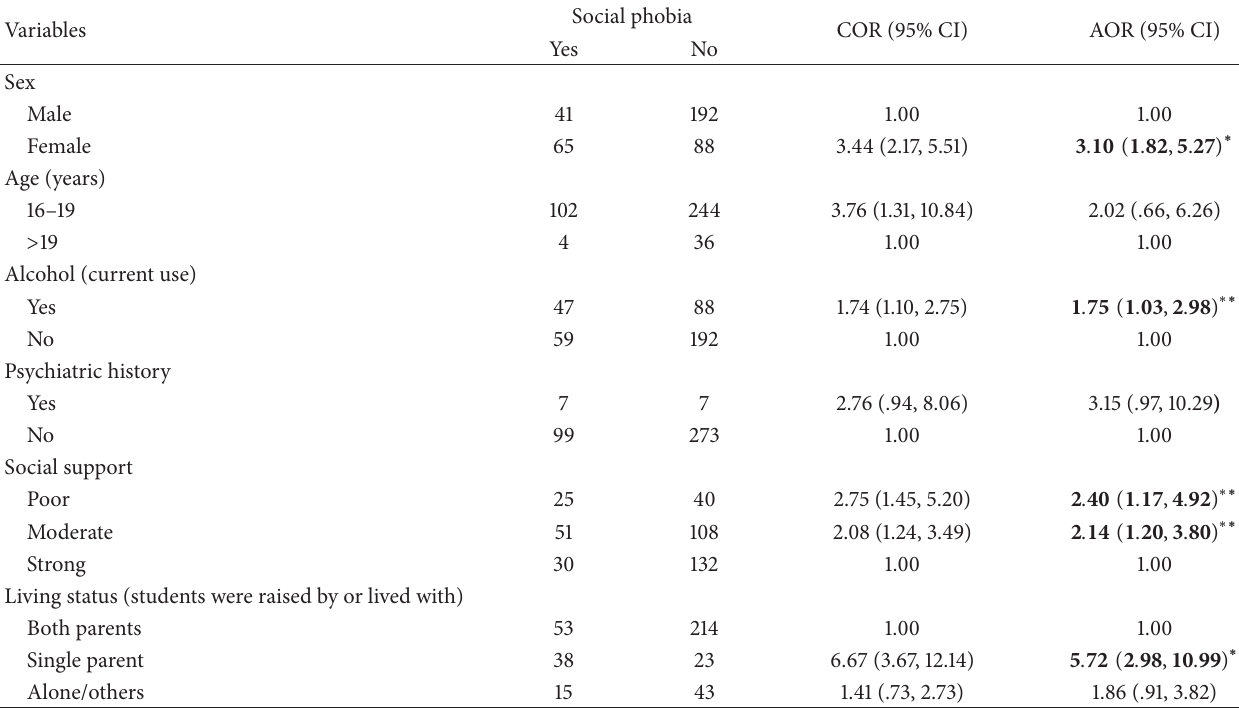
Table 3: Factors associated with social